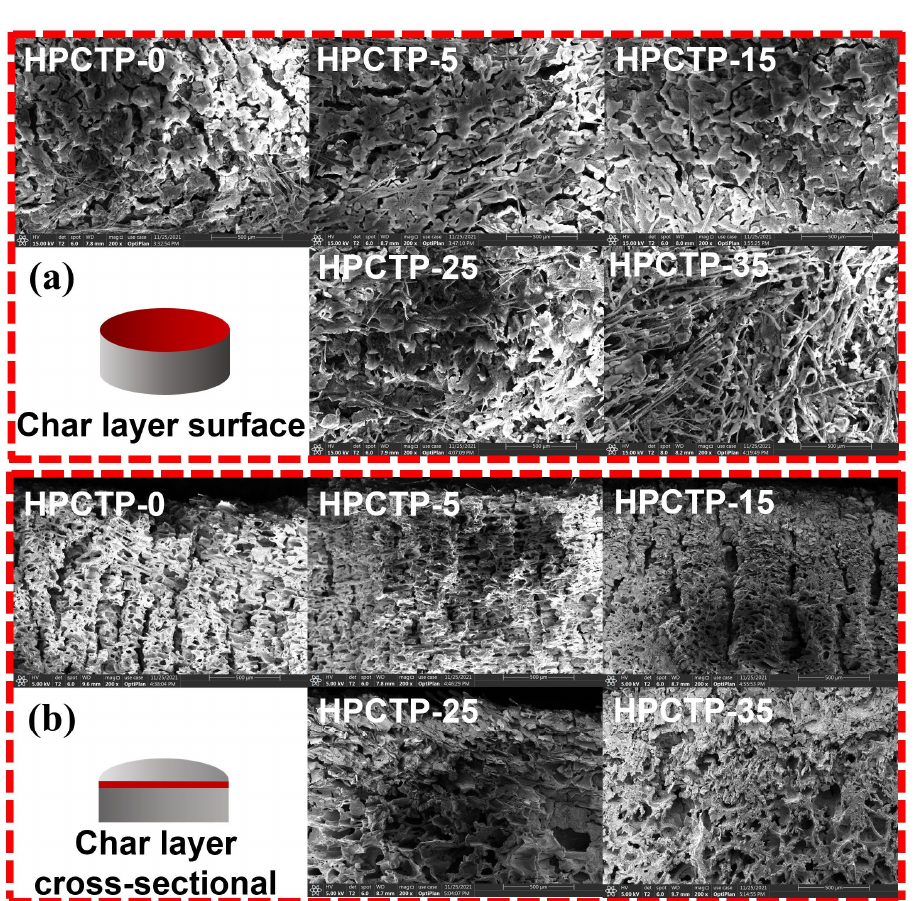
Figure 6. Morphology of the char layer of HPCTP-containing EMVSR composites under 4 MW/m 2 heat flow: ( a ) the surface and ( b ) cross-sectional morphology of char layer.